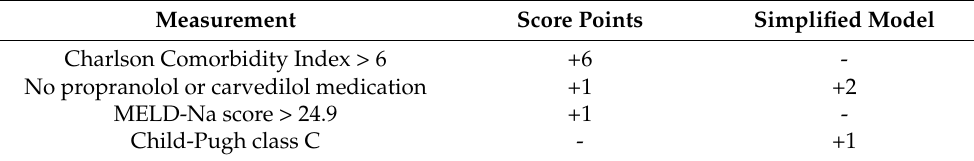
Table 1. Cont. Measurement Score Points Simplified Model Charlson Comorbidity Index > 6 +6 - +1